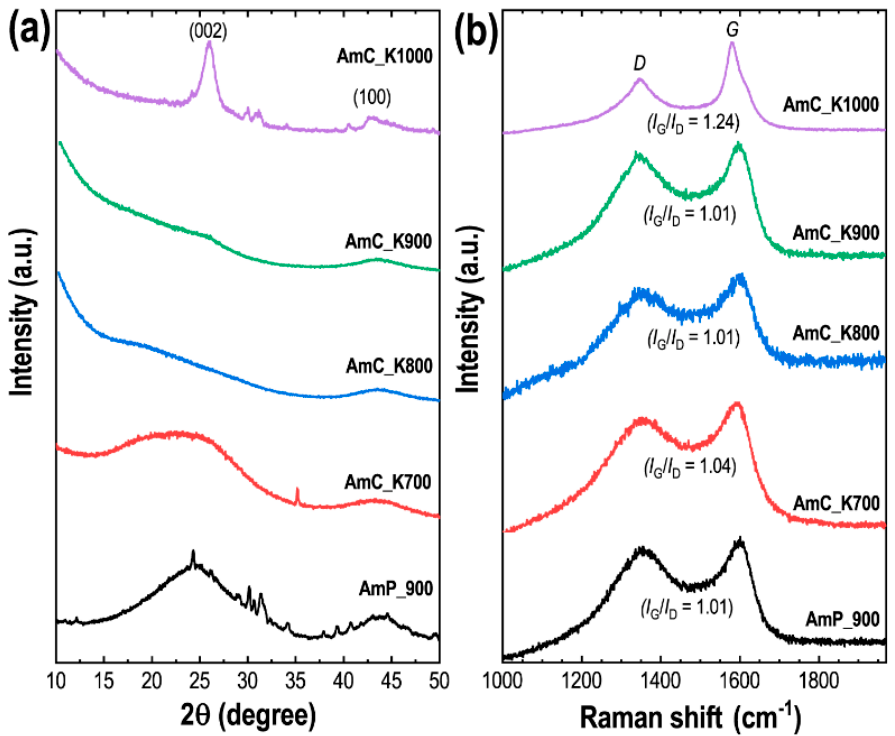
Figure 3. ( a ) pXRD patterns of AmP_900, AmC_K700, AmC_K800, AmC_K900, and AmC_K1000; ( b ) the corresponding Raman scattering spectra.